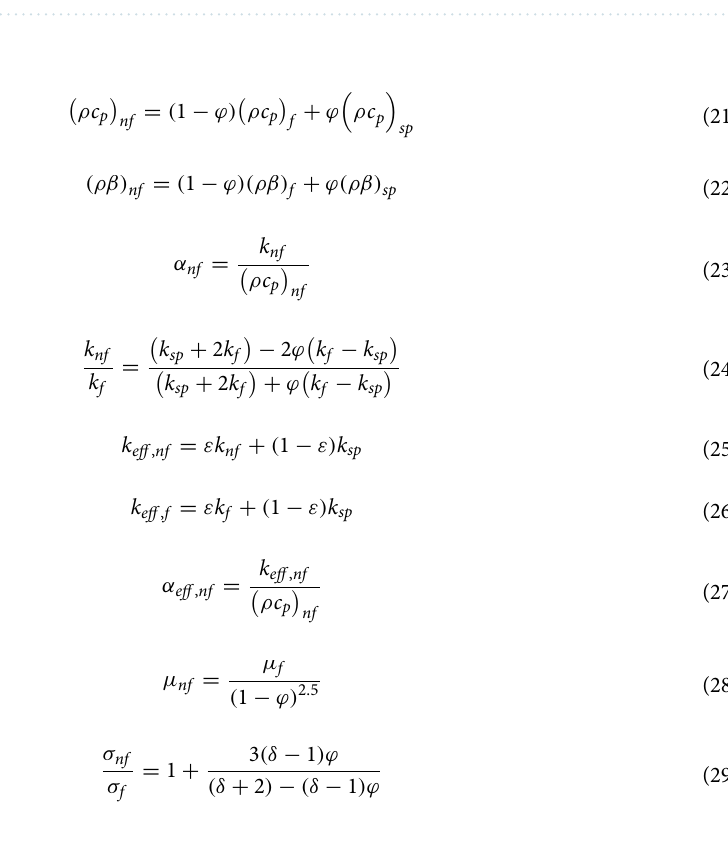
Table 2. Grid independent test average Nusselt number on hot surface at (Re = 200, Ri = 10, Da = 1e−3 λ = 5, φ = 0.04, Ha = 20, γ = 45, A = 0.15, N = 3). Significant values are in bold.